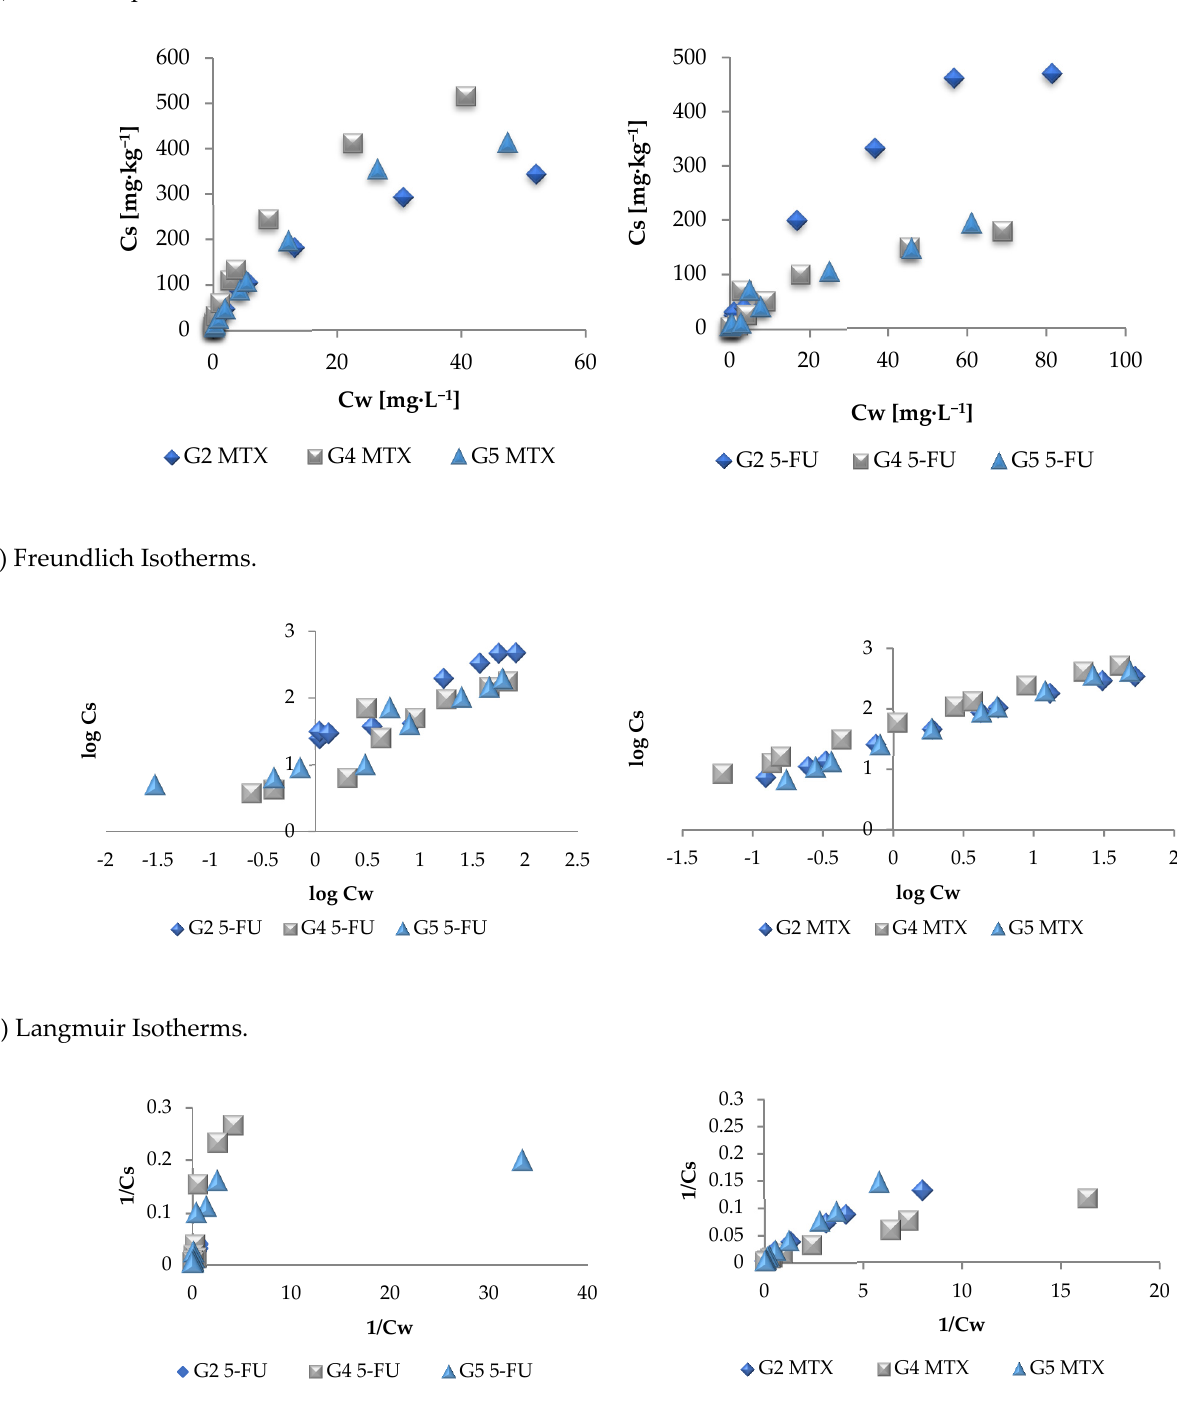
Figure 1. Selected 5-FU and MTX sorption isotherms (Basic conditions: medium: 0.01 M CaCl 2 ; concentration range of ADs: from 0.625 to 100 mg · L − 1 ; adsorption equilibrium time: 24 h; optimal soil − to − liquid (S/L) ratio: 5-FU (G2 soil = 1:25; G4 and G5 soil = 1:5); MTX (G2, G4, G5 soil = 1:15).